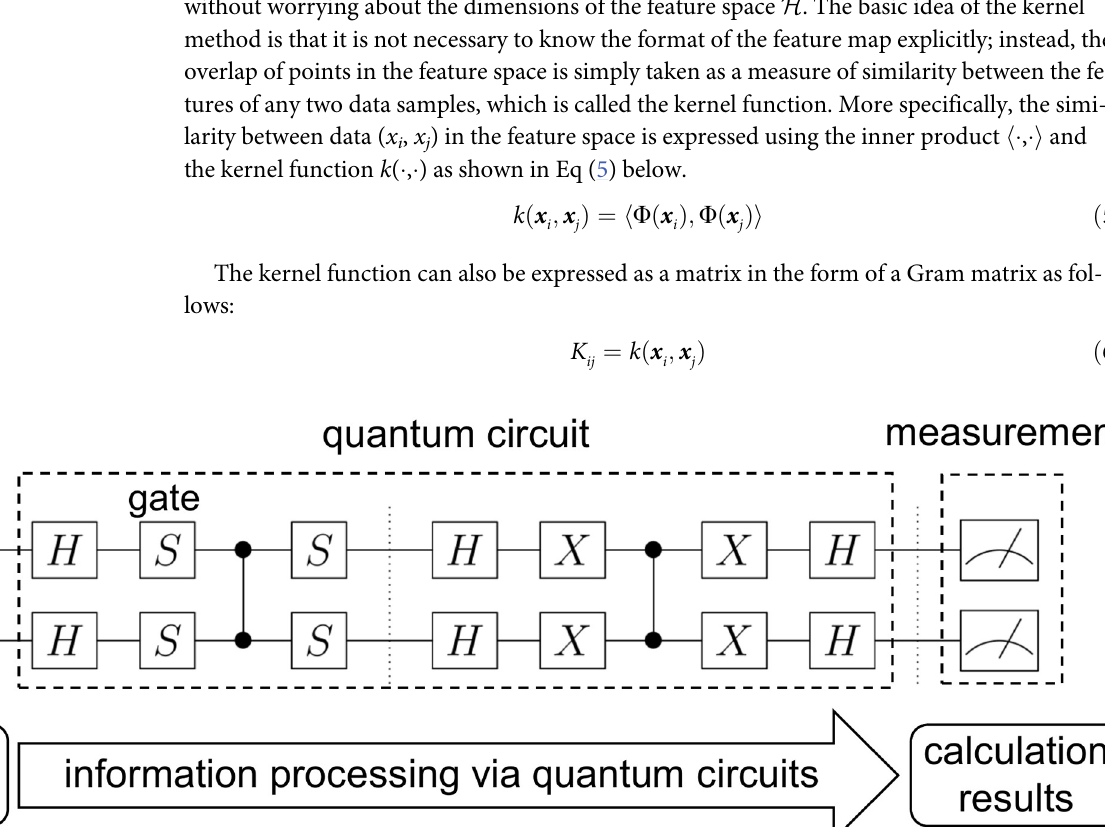
PLOS ONE | https://doi.org/10.1371/journal.pone.0283933 April 5,